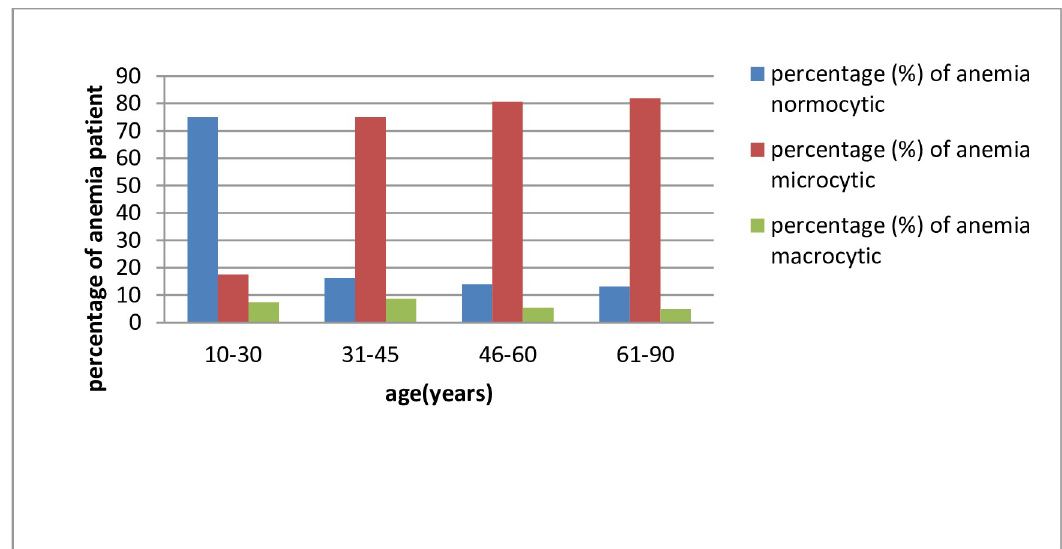
Fig 3. Prevalence of normocytic, microcytic and macrocytic by